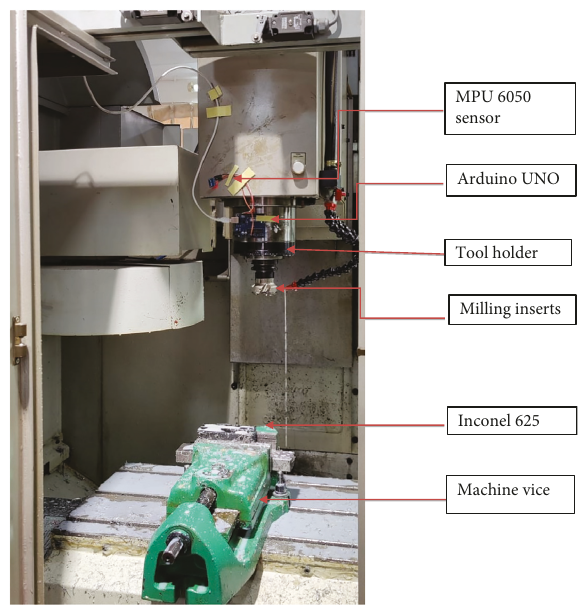
Figure 7: Machining